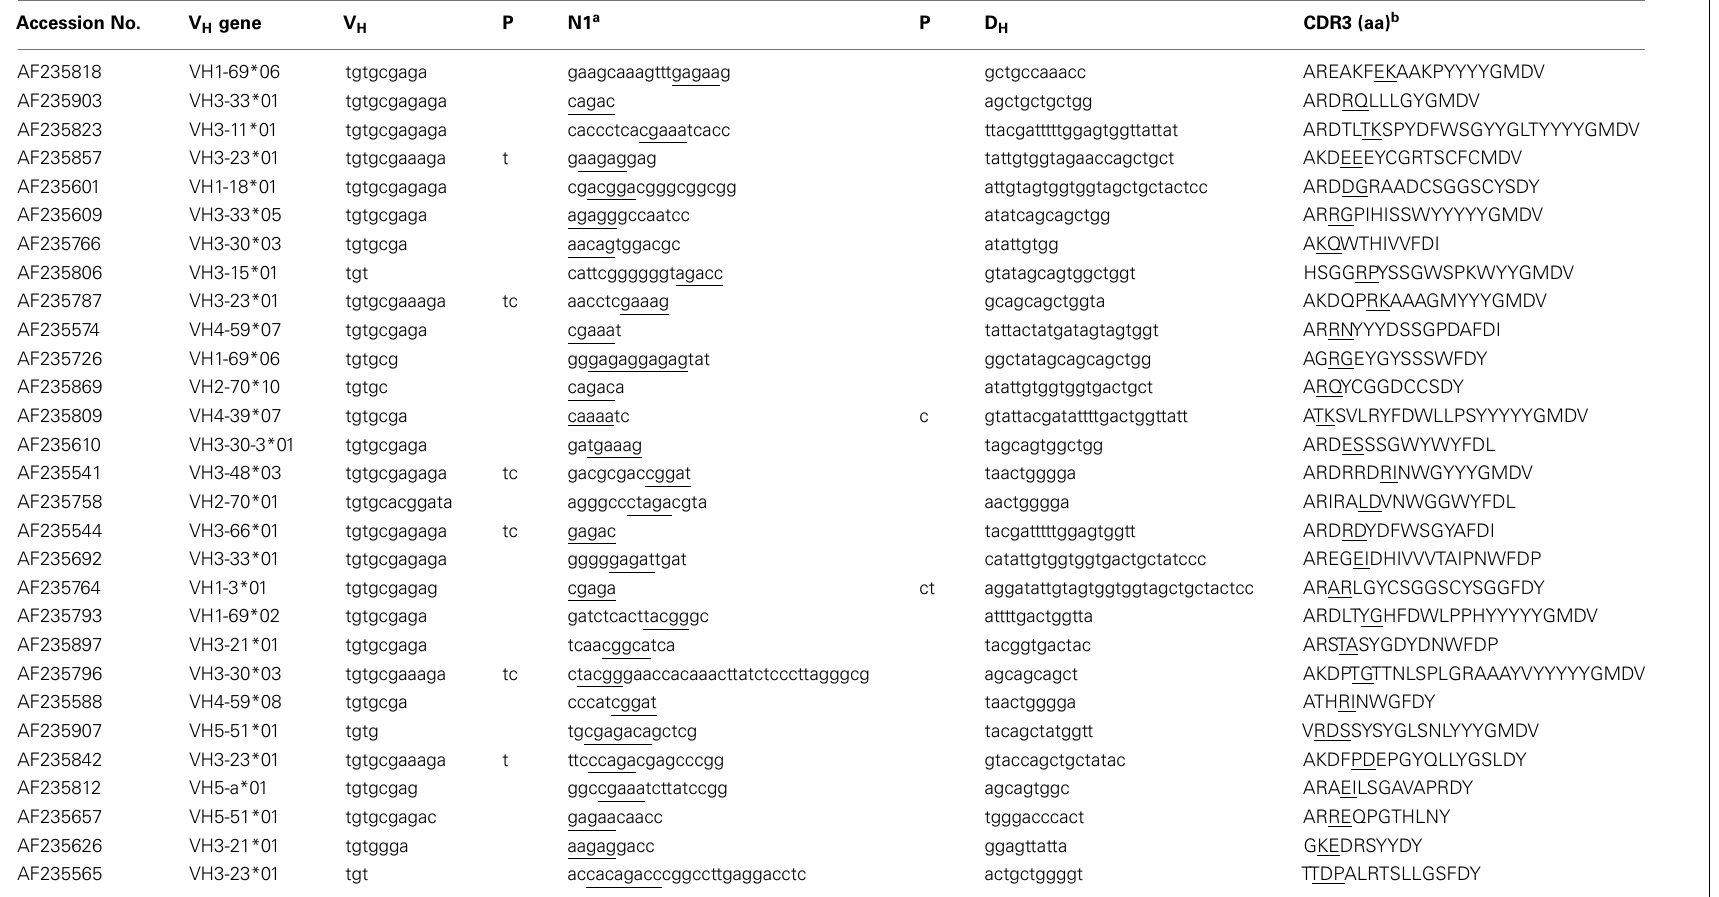
Table 2 | Identification of potentialV H replacement products in human IgH sequences